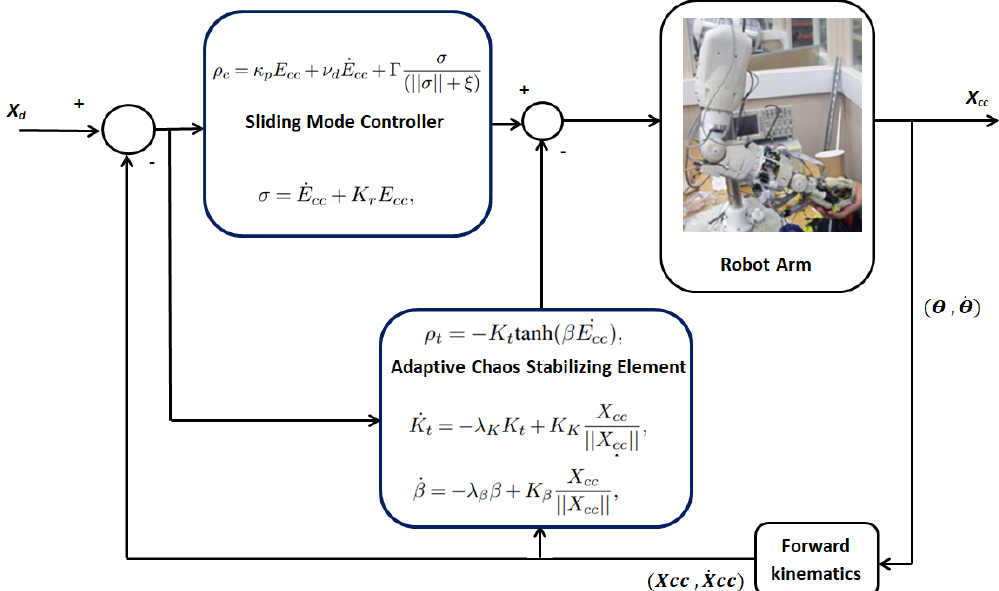
Figure 4. Block diagram of the